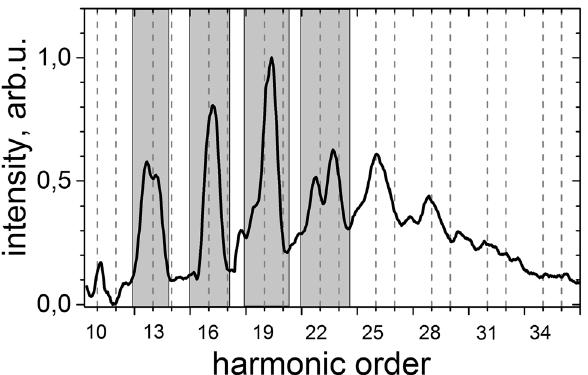
Figure 4. Shadowed area show parts of the XUV-continuum separated for polrization measurements.